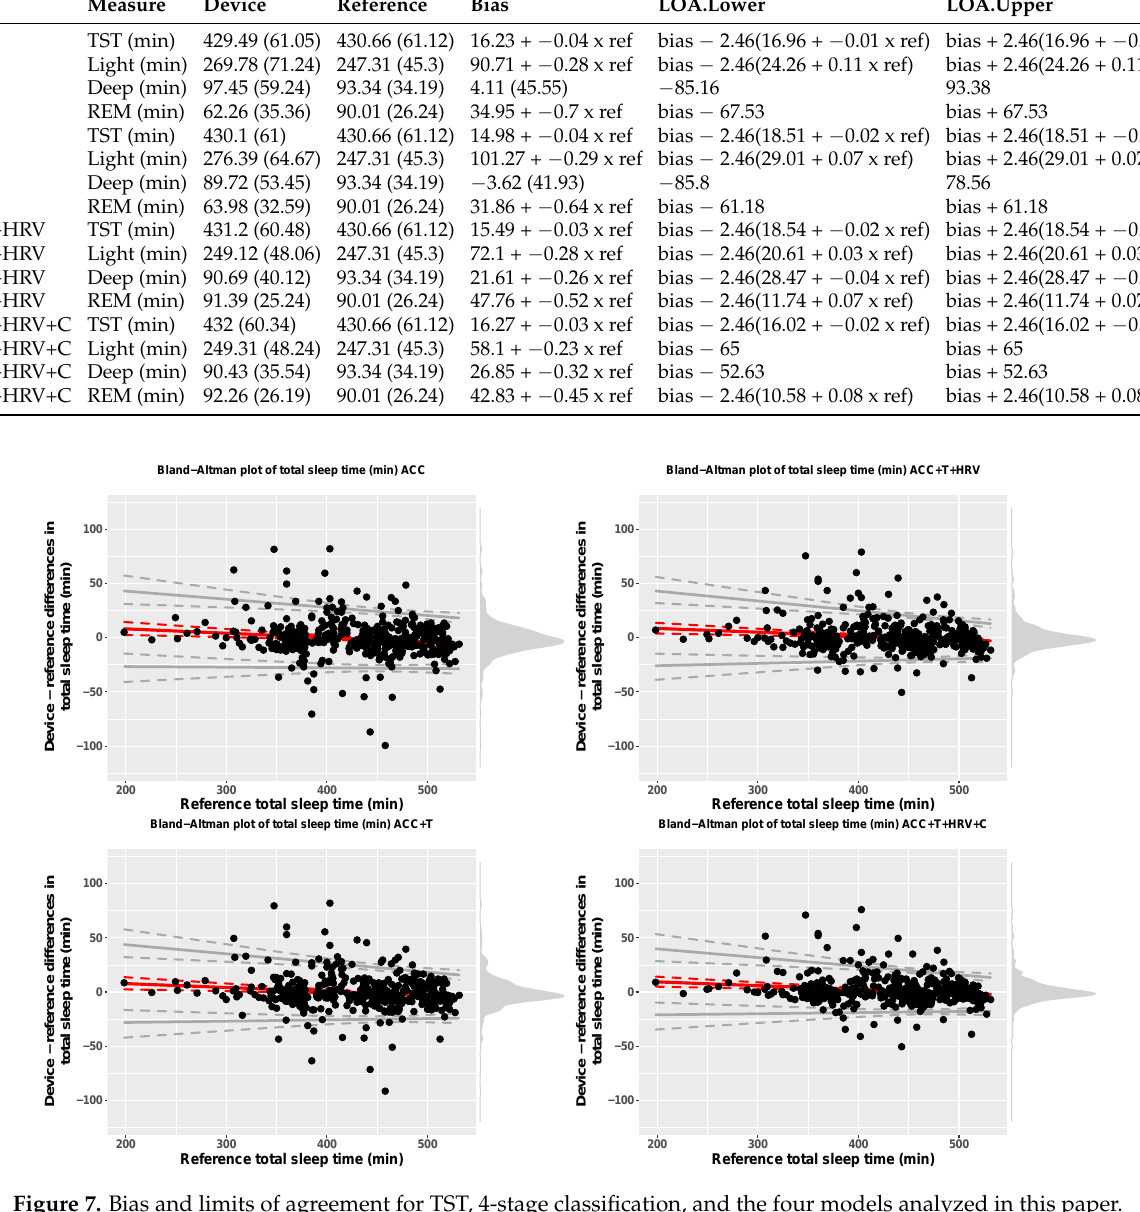
Figure 7. Bias and limits of agreement for TST, 4-stage classification, and the four models analyzed in this